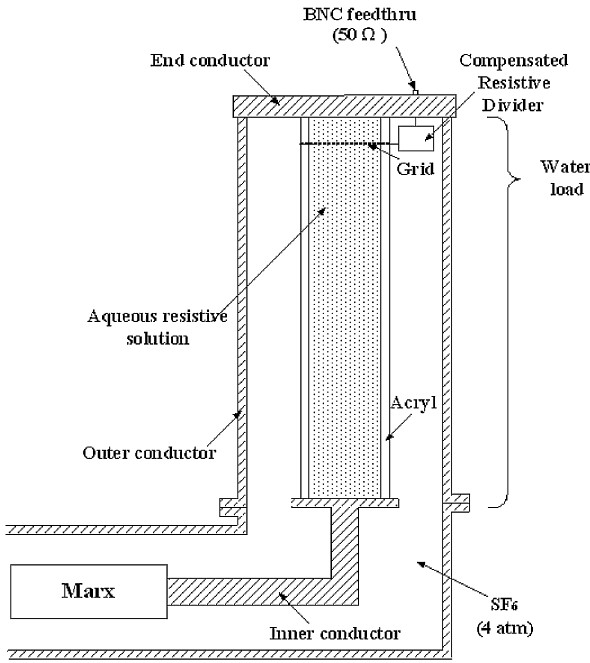
FIG. 2. Schematic of a coaxial water load combined with the Marx